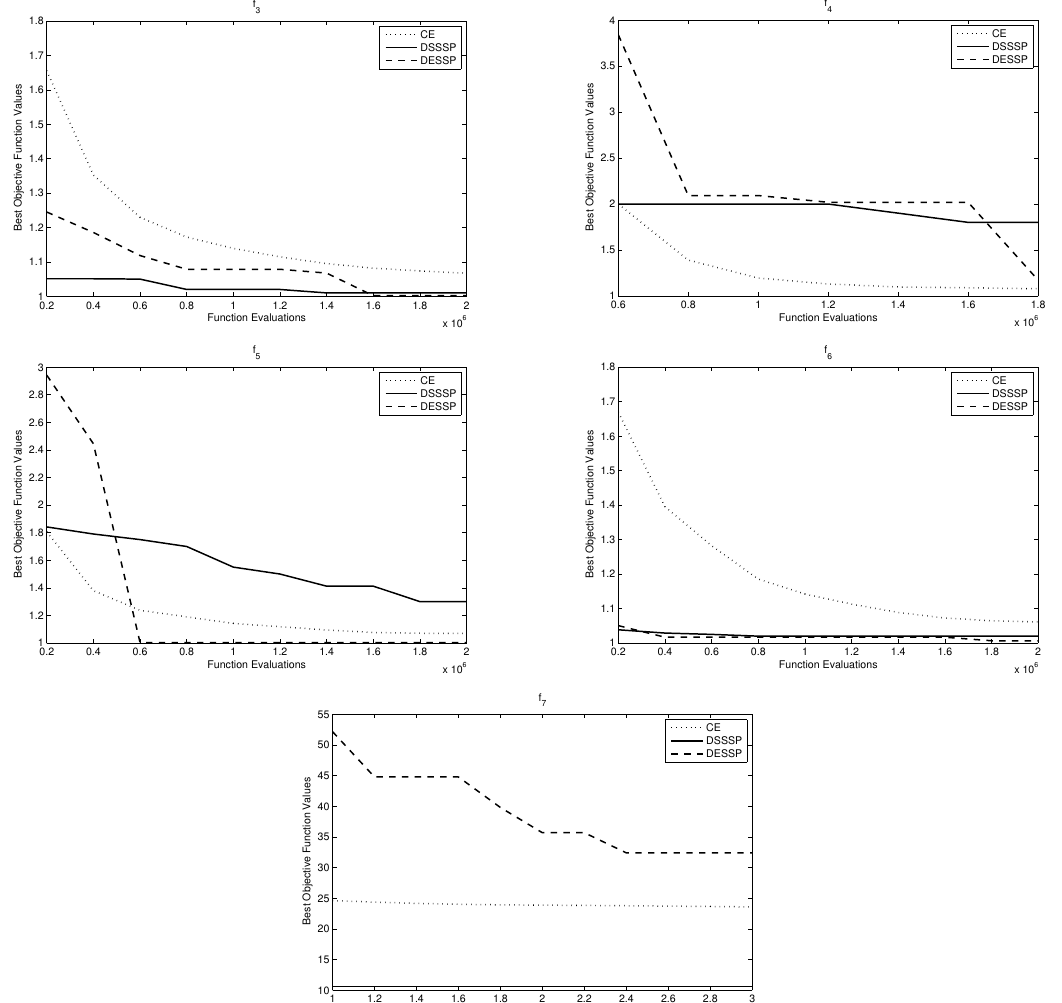
Figure 10. Comparison using test functions f 1 – f 7